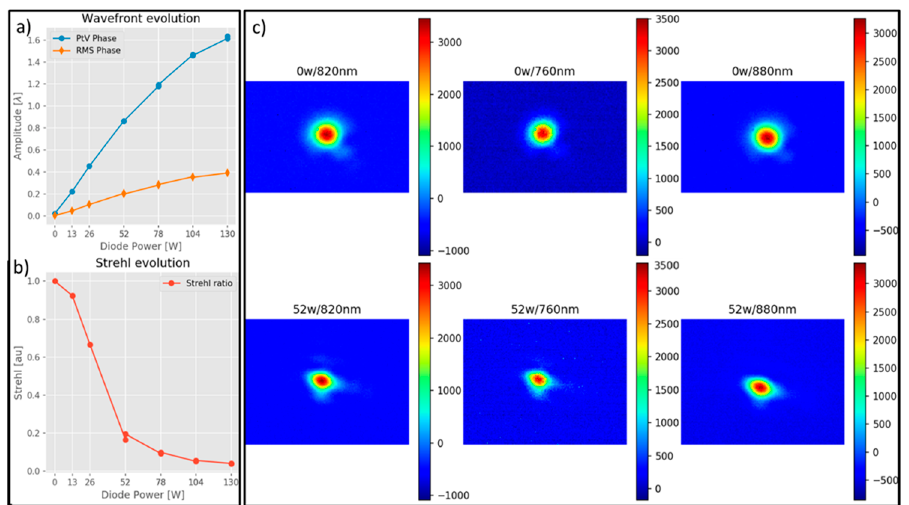
Figure 11. The (increasing) power sent on both input and output spots. ( a ) Wavefront degradation. ( b ) Strehl ratio degradation—the graph reports the ratio between the Strehl ratio at a given power and that at zero heating power. ( c ) Upper line: far field at 760 nm, 820 nm, 880 nm for 0 W heating power. Lower line: far field at 760 nm, 820 nm, 880 nm for 52 W heating power. Pairs of spots at each wavelength are normalized at the same peak intensity to allow a clearer comparison of the spot shapes. Spots at different wavelengths cannot be compared directly due to the different shape of the unperturbed beam.